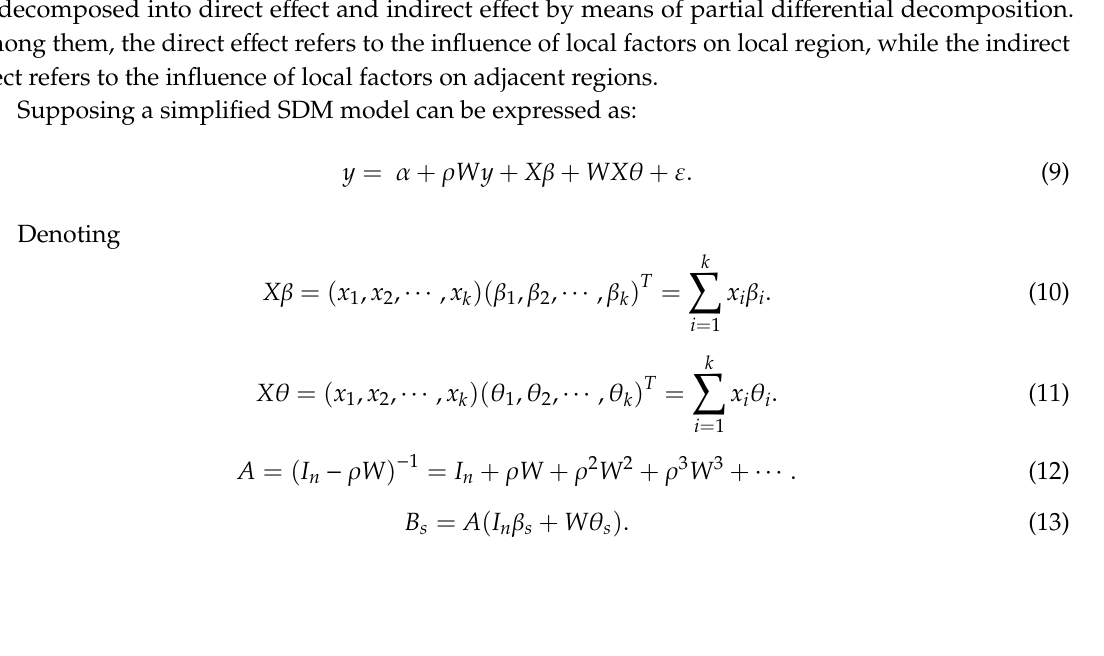
Note: *** and ** respectively represent significant at the levels of 1% and